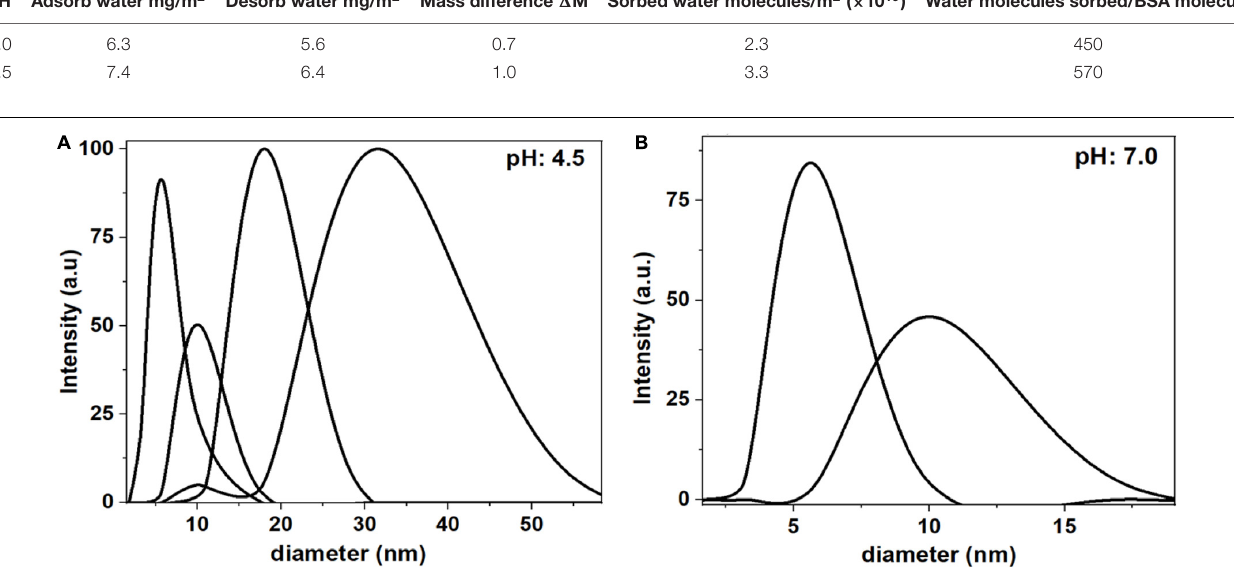
FIGURE 3 | Dynamic Light Scattering (DLS) measurements of BSA in saline at pH 4.5 (A) and pH 7 (B) . At pH 4.5, the BSA shows multiple size distribution with the maximum at 5, 10, 20, and 50 nm. At pH 7.0, the BSA shows only two size distributions at 5 and 10 nm.